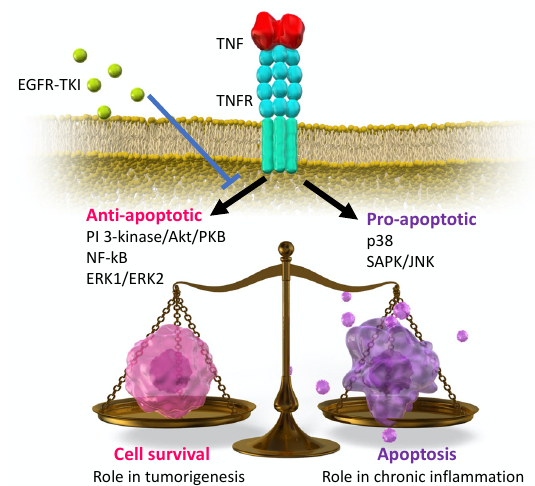
Figure 1. Schematic image of the downstream signaling of tumor necrosis factor (TNF); the balanced regulation of cell survival.